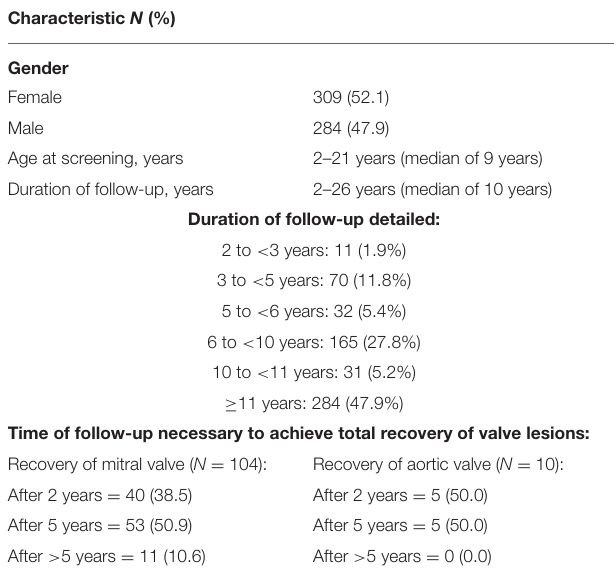
TABLE 1 | Rheumatic fever patients’ characteristics (group I and